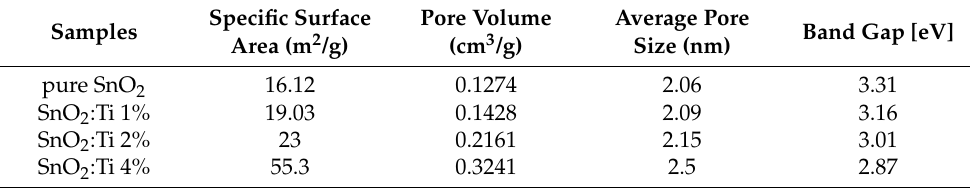
Table 2. Nitrogen sorption, porosimetry data and band gap energies of Ti-SnO 2 NPs.